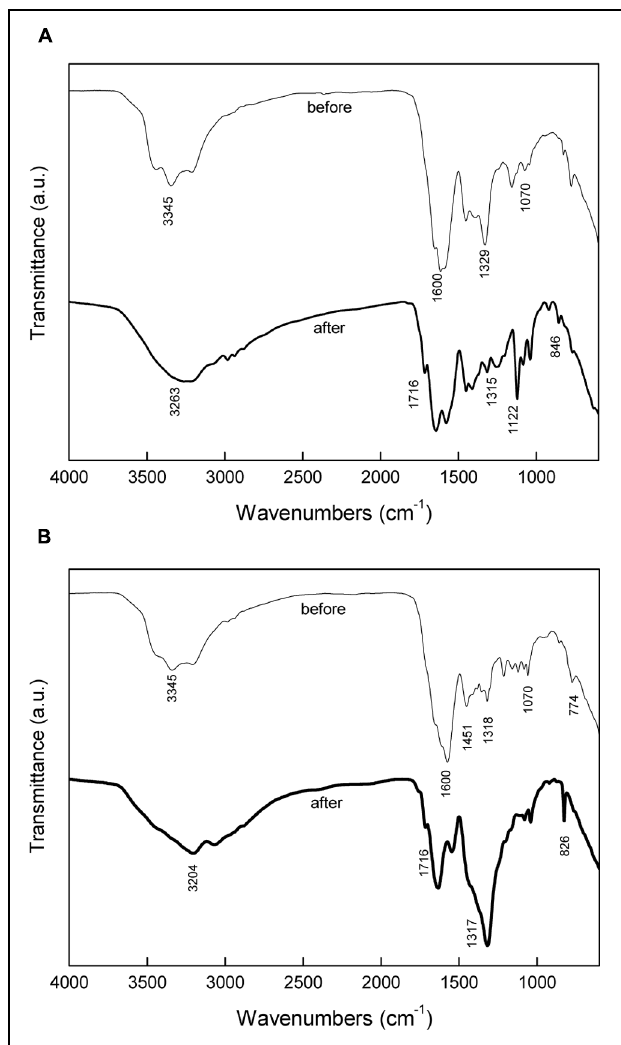
FIGURE 5 | Fourier transform infrared spectroscopy (FT-IR) analysis of media before and after precipitation: (A) inorganic calcium source; (B) organic calcium